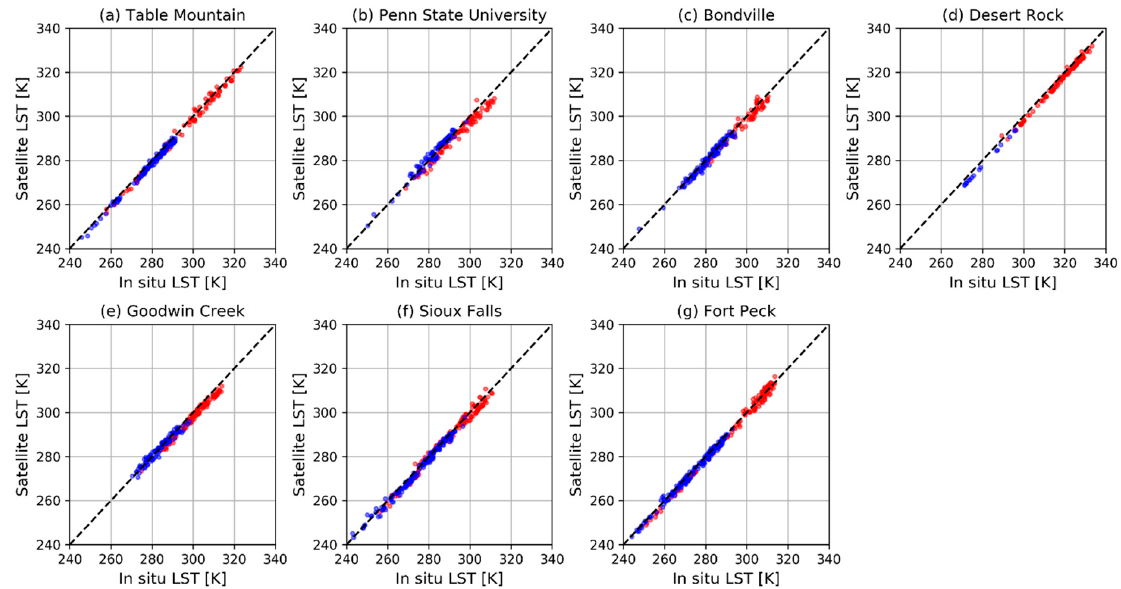
Figure 3. LST validation for the GlobTemperature Aqua-MODIS LST product (GT_MYD_2P) over seven SURFRAD validation sites: ( a ) Table Mountain, ( b ) Penn State University, ( c ) Bondville, ( d ) Desert Rock, ( e ) Goodwin Creek, ( f ) Sioux Falls, ( g ) Fort Peck; covering the year of 2011. Daytime matchups are in red, and nighttime matchups are in blue.